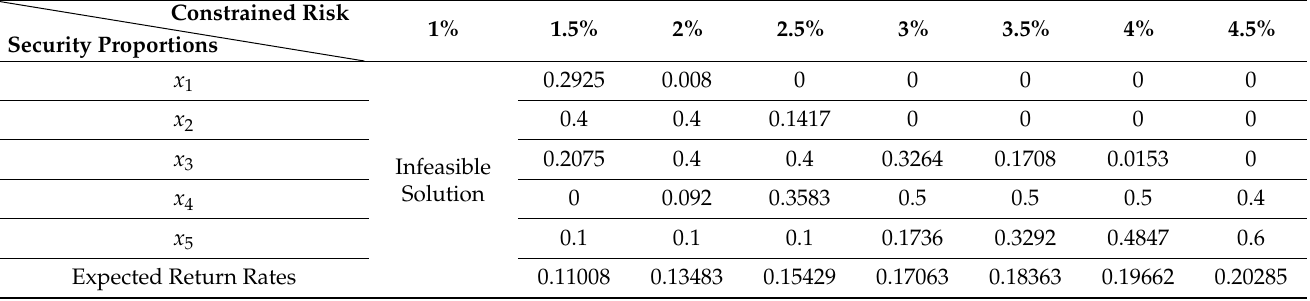
Table 3. The dimension with t = 2, and s = 1 with a guaranteed return rate (cid:101) p 3 in the proposed model.